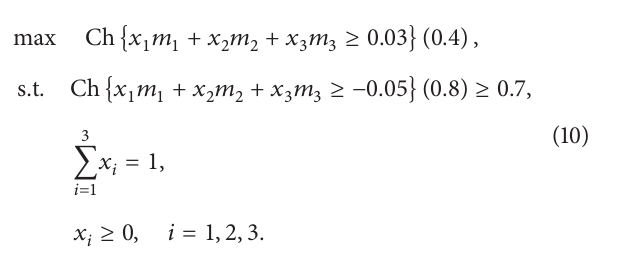
Table 1: The distributions of stocks 𝑚 1 , 𝑚 2 , and 𝑚 3 .